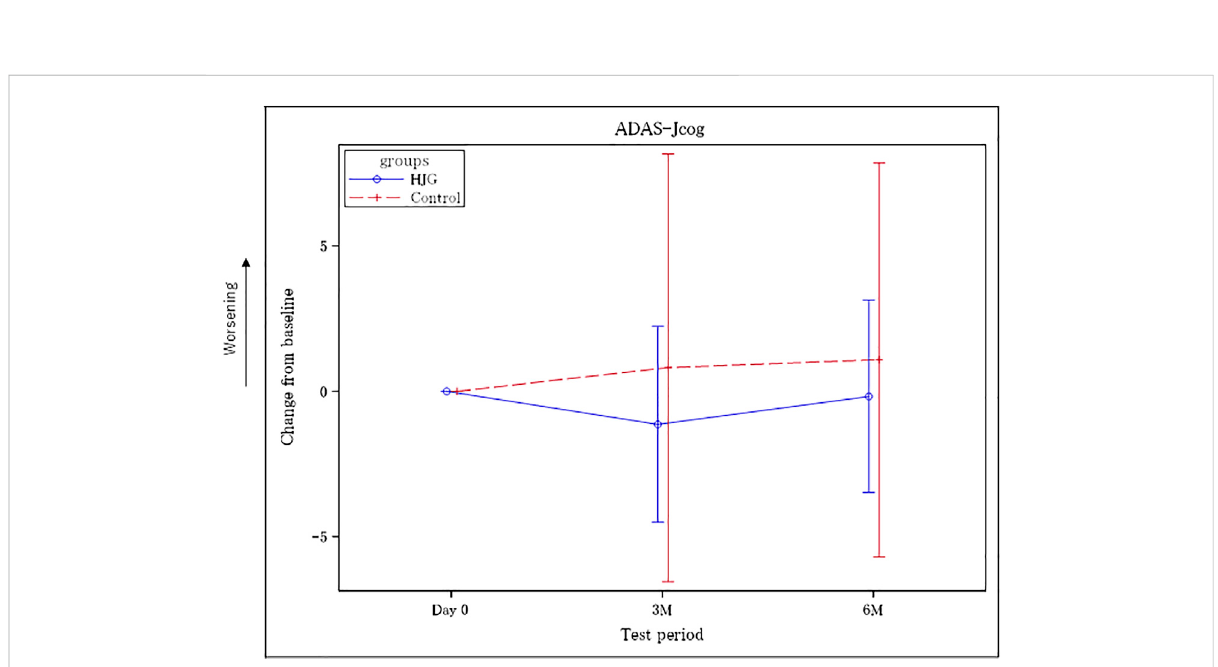
FIGURE 2 Difference between the HJG and control groups in the change from baseline to 3 and 6 months: ADAS-Jcog.